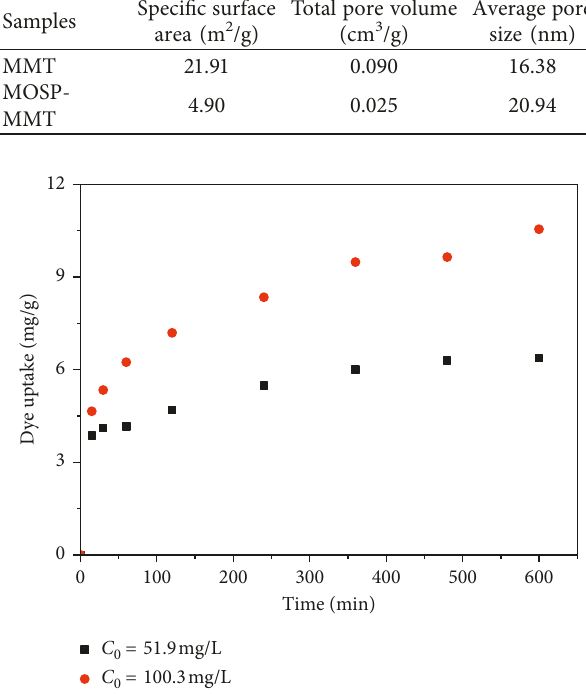
Figure 3: Effect of reaction time on RR-2 uptake ( T pH (cid:31)